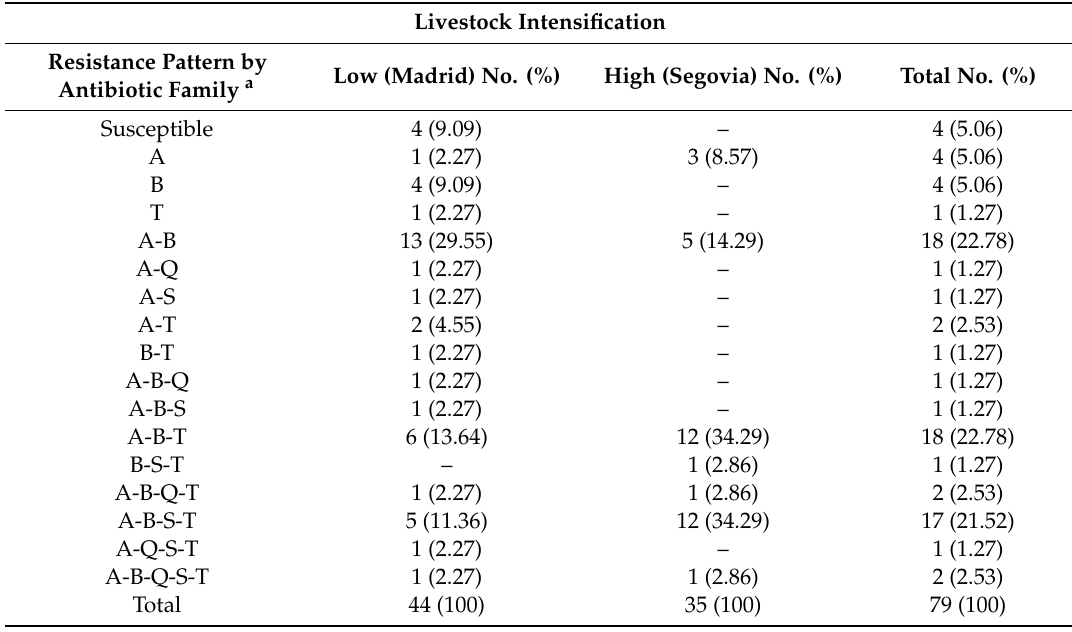
Figure 2. ( a ) Mean number (± SE) of resistant E. coli isolates to different agents and antibiotic families in red kite droppings sampled in low- and high-intensity farming areas in Central Spain. ( b ) frequency (%) of resistant isolates to each number of antibiotic families in the low- and high-intensity farming areas. Table 2. Characterization according to resistance patterns by antibiotic family of E. coli isolated from feces of red kites from low- and high-intensity farming areas in central